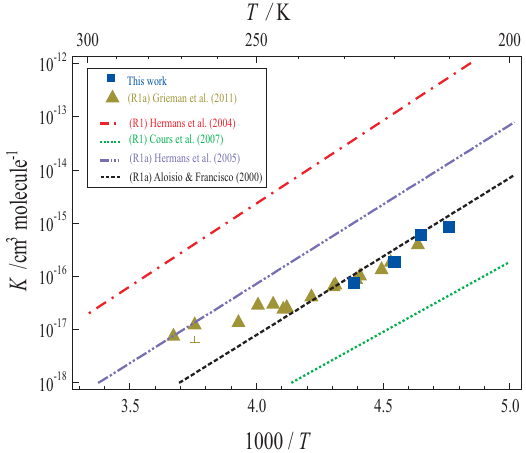
Fig. 4. van’t Hoff plot used to compare determinations of K 1 (and K 1a ) . The red dot-dashed line and green dotted lines de- pict the (R1) results from Hermans et al. and Cours et al. respec- tively. Also displayed are results for (R1a): from Aloisio and Fran- cisco (2000) K 1a (200–300 K) = 1.25 × 10 − 29 exp(6790/ T ) cm 3 molecule − 1 (the black dashed line); from Hermans et al. (2005) K 1a (200–300 K) = 1.25 × 10 − 29 exp(7248/ T ) cm 3 molecule − 1 (the purple dot-dashed line); and recent experimental results (green triangles) from Grieman et al. (2011). The blue square datapoints depict results from this work, which appear to describe K 1a (T )